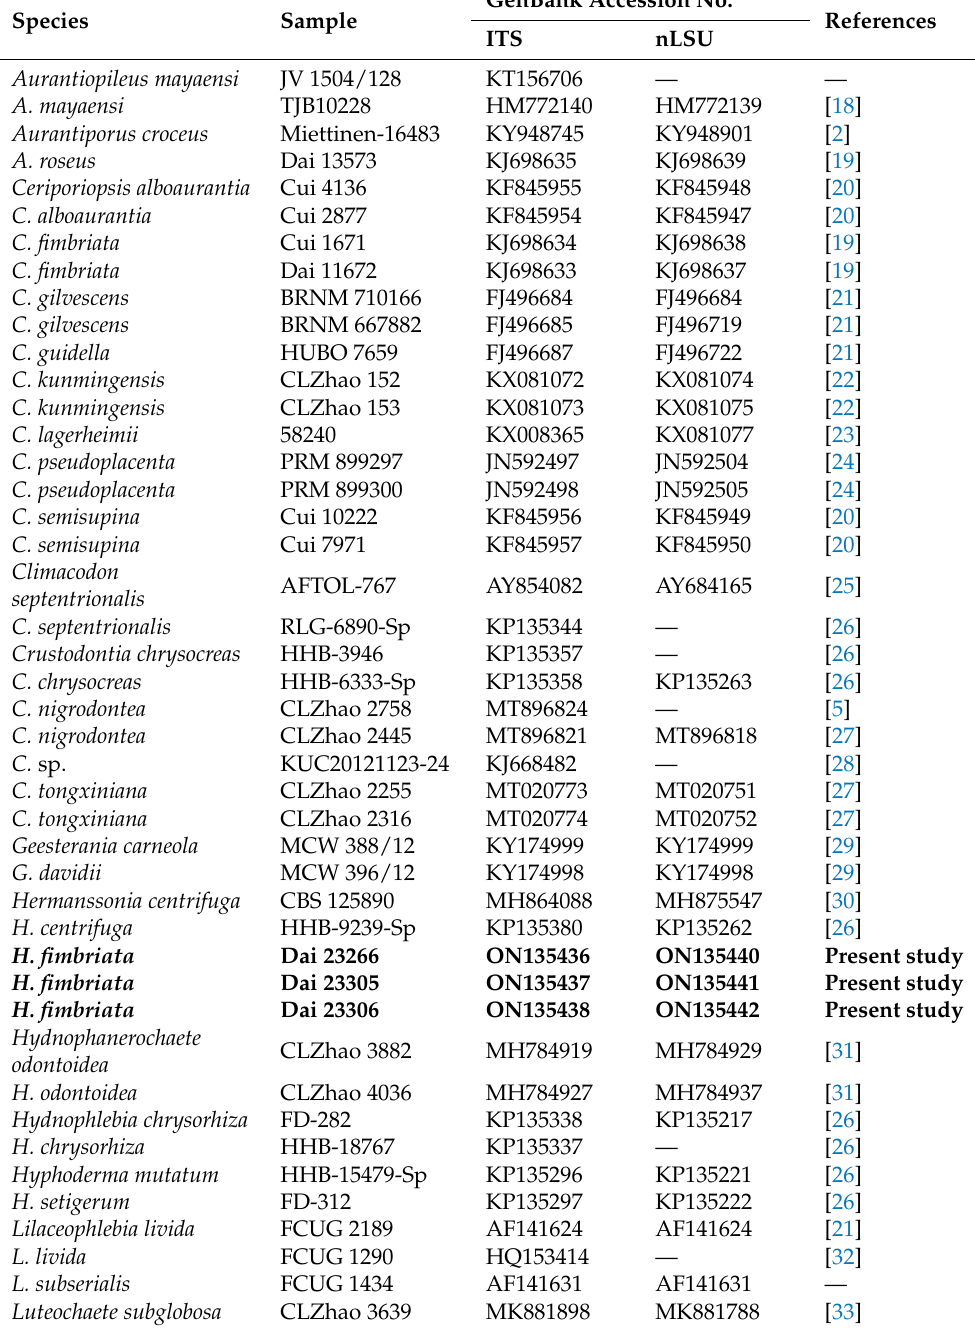
Table 1. Taxa information and GenBank accession numbers of the sequences used in this